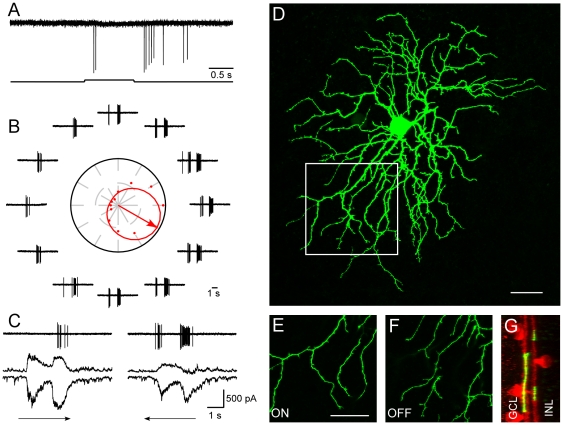
Normal DSGCs can be found in retinas receiving 16 to 19 daily BMI injections.A: A DSGC responded to the onset and termination of a stationary flashing spot. B: Directional responses to a rectangle moving in 12 directions. The preferred direction is represented by the arrow in the middle of polar plot surrounded by traces of action potentials. C: Asymmetrical synaptic inputs recorded when membrane potential was held at −65 mV and 0 mV, respectively. Much larger inhibitory inputs were observed when visual stimulus was moving in the null direction. D: Dendritic morphology of the recorded cell. A section of the dendritic field was enlarged showing clear ON (E) and OFF (F) segregation. Tight costratification with cholinergic plexus was clear (G). Scale bar: 30 µm.